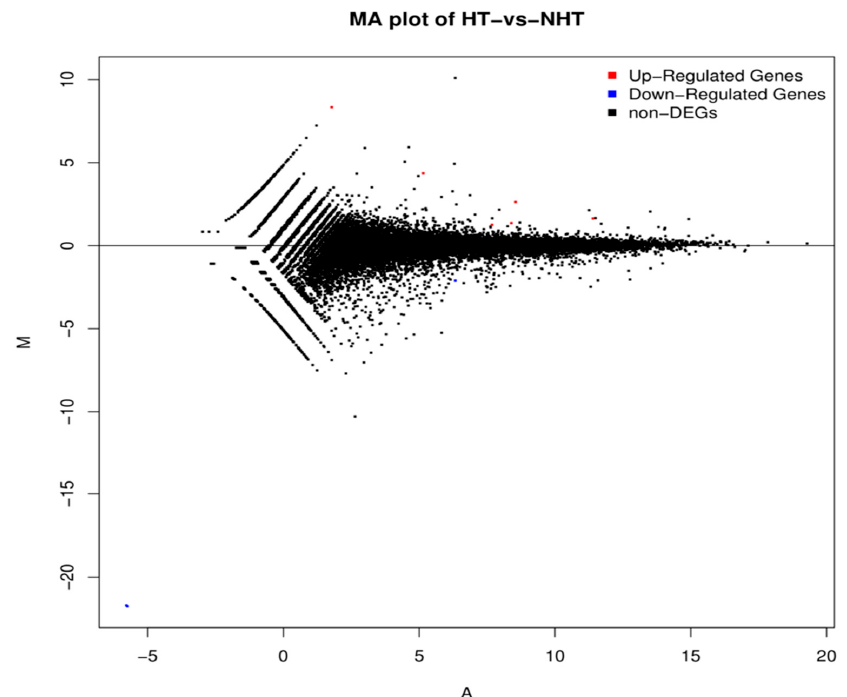
Figure 2. MA plot showing di ff erentially expressed genes between HT and NHT Chinese Holstein dairy cows. M is the intensity ratio representing the Y -axis; A is the average intensity for a dot representing the X -axis. Red and blue dots represent up- and down-regulated genes, respectively while black dots represent the genes without significant di ff erential expression.